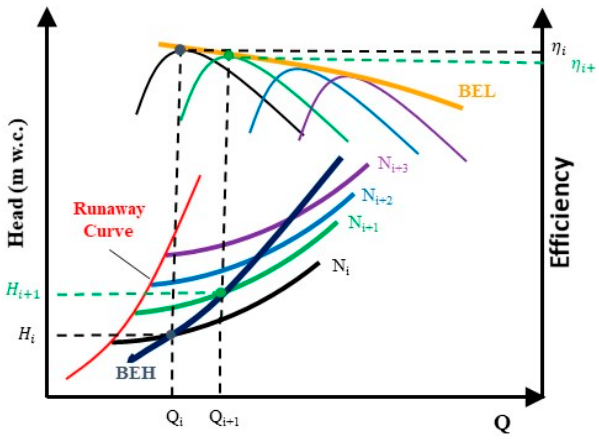
Figure 1. BEL and BEH operation scheme.